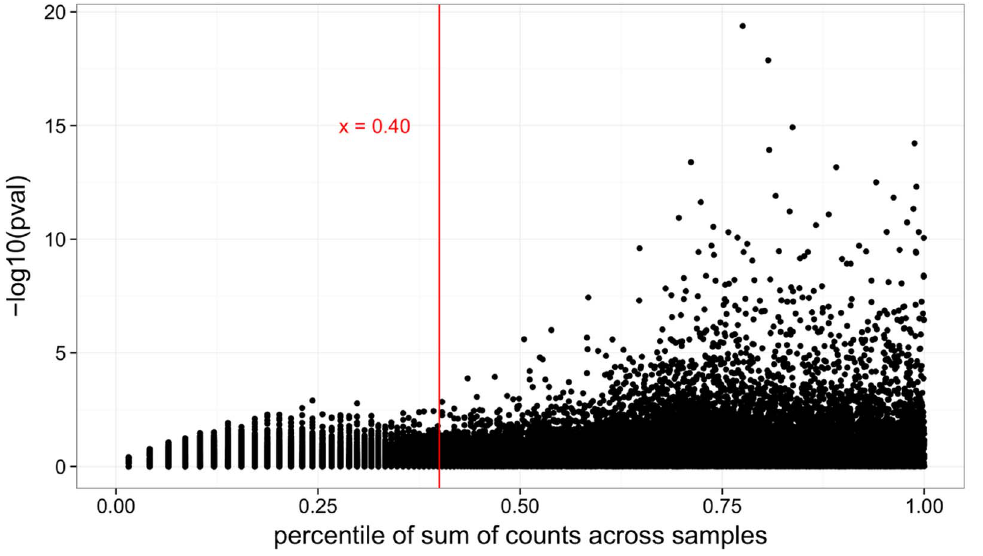
Figure 15. Genes with low read count are filtered prior to testing for differential expression. Each point represents a gene. We are able to increase our detection power by eliminating tests which have read counts below the 40th percentile, and therefore would have small probability of attaining significance [6]. doi:10.1371/journal.pone.0092111.g015 PLOS ONE |